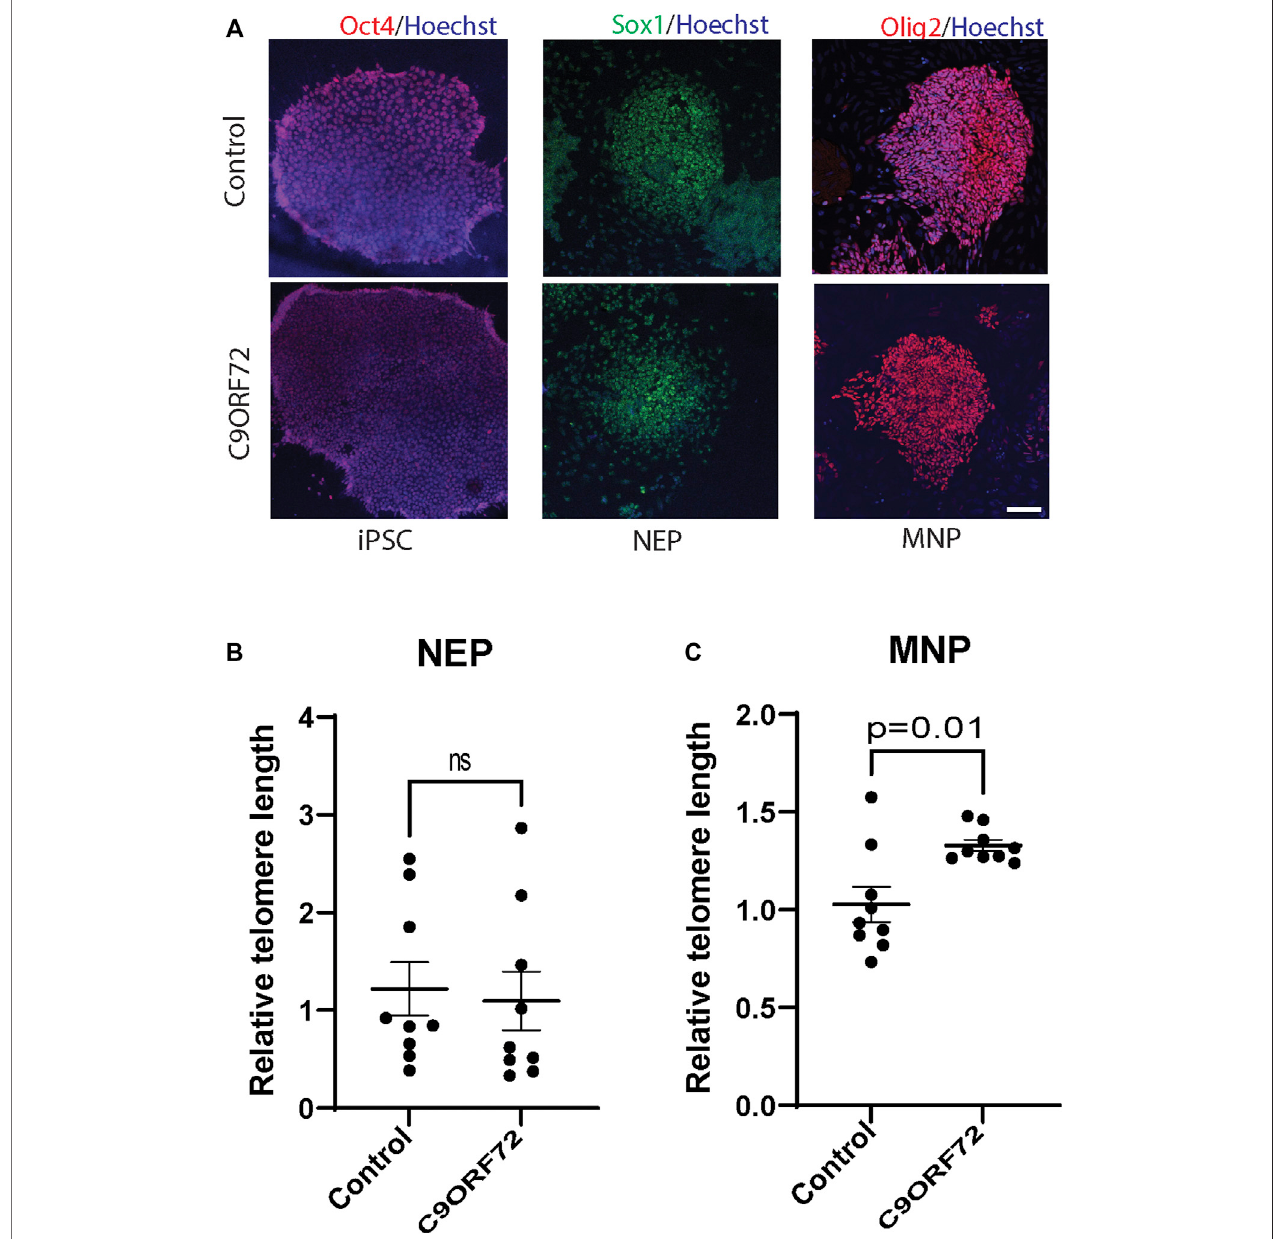
FIGURE 1 | Telomere length analysis during the differentiation of iPSCs to MNs from controls and C9ORF72 repeat expansion carriers. Representative images of control and C9ORF72 (A) iPSC s , NEP, and MNP. Telomere length quanti fi cation in (B) NEP and (C) MNP, from 3 controls and 3 C9ORF72 iPSC lines , from 3 independent differentiations. Two-tailed t -test with Welch ’ s correction was applied. ns, not signi fi cant. Scale bar = 20 µm.